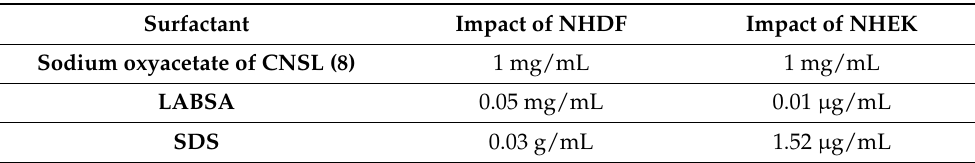
Table 13. Effect on viability of NHDF (Normal Human Dermal Fibroblasts) and of NHEK (Normal Human Epidermal Keratinocytes).